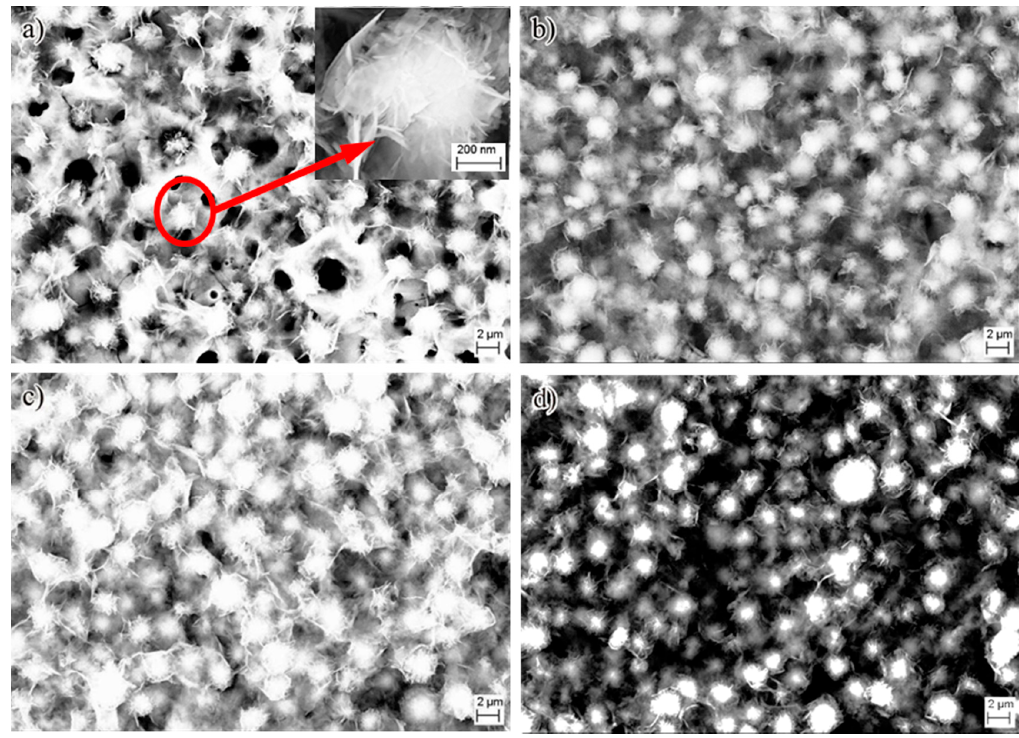
Figure 7. Surface morphology of the samples after soaking in biomimetic mineralization solution for